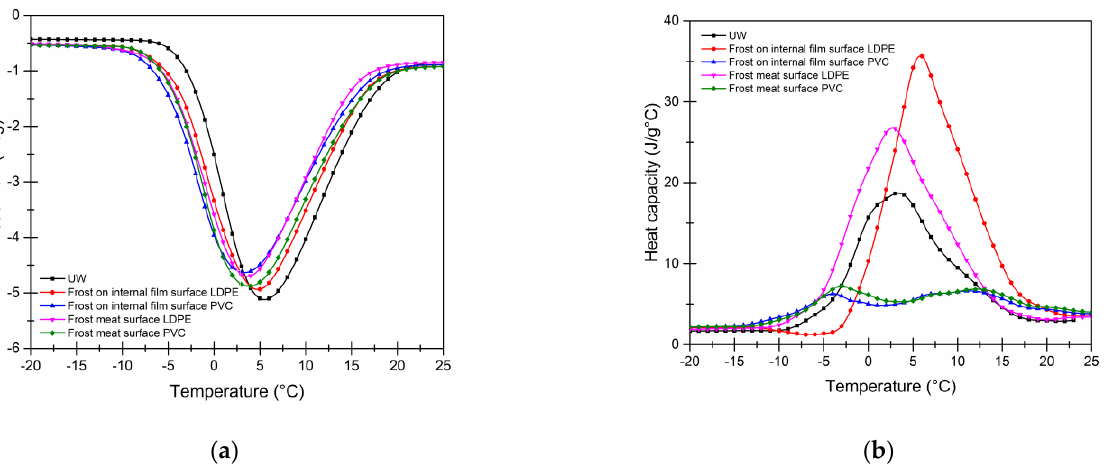
Figure 7. ( a ) Heat flow (W/g). ( b ) Specific heat (J/g °C) of frost water from the surface of the packages and meat. packages and meat.